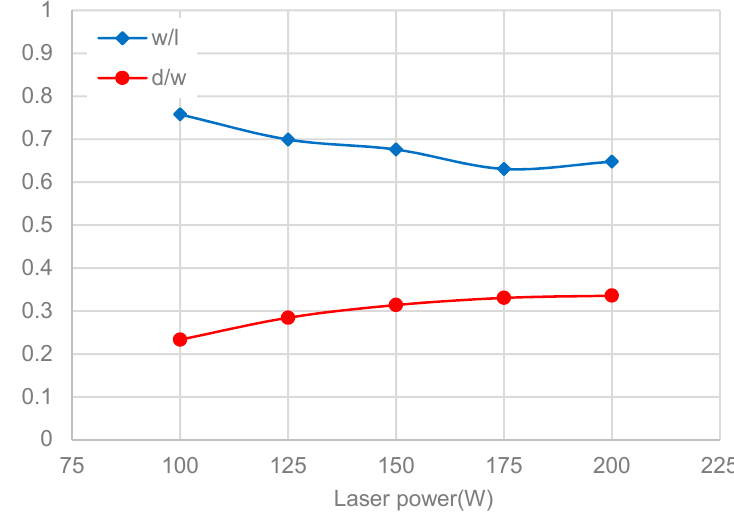
Figure 13. Ratio of width/length and depth/width at different laser power levels.